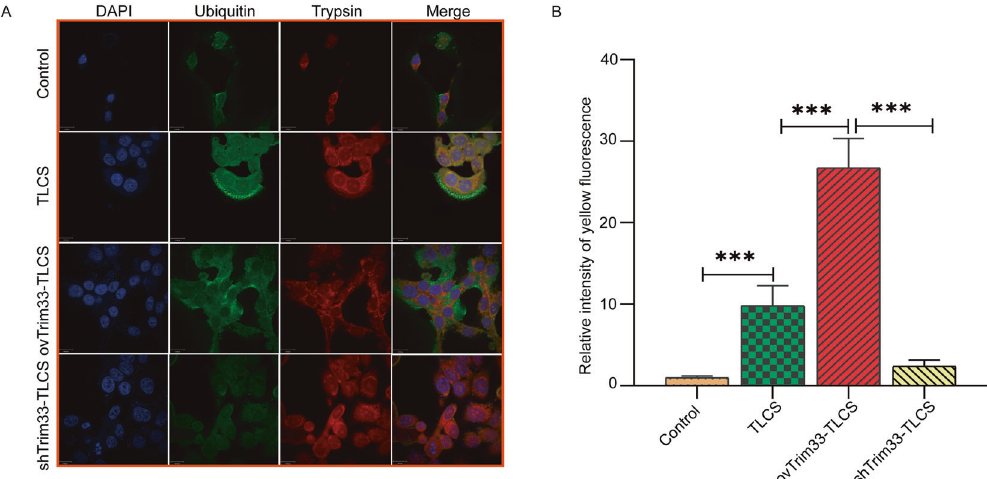
Fig. 4 Trim33 can promote the ubiquitination of activated zymogen. A Co-localization analysis of endogenous ubiquitin and zymogen particles, showing DAPI-labeled nucleus, green fl uorescein-labeled ubiquitin antibody, red fl uorescein-labeled trypsin, and yellow fl uorescence represents the co-localization of ubiquitin and activated zymogen; B the relative intensity of yellow fl uorescence in each group ( t -test, *** p <